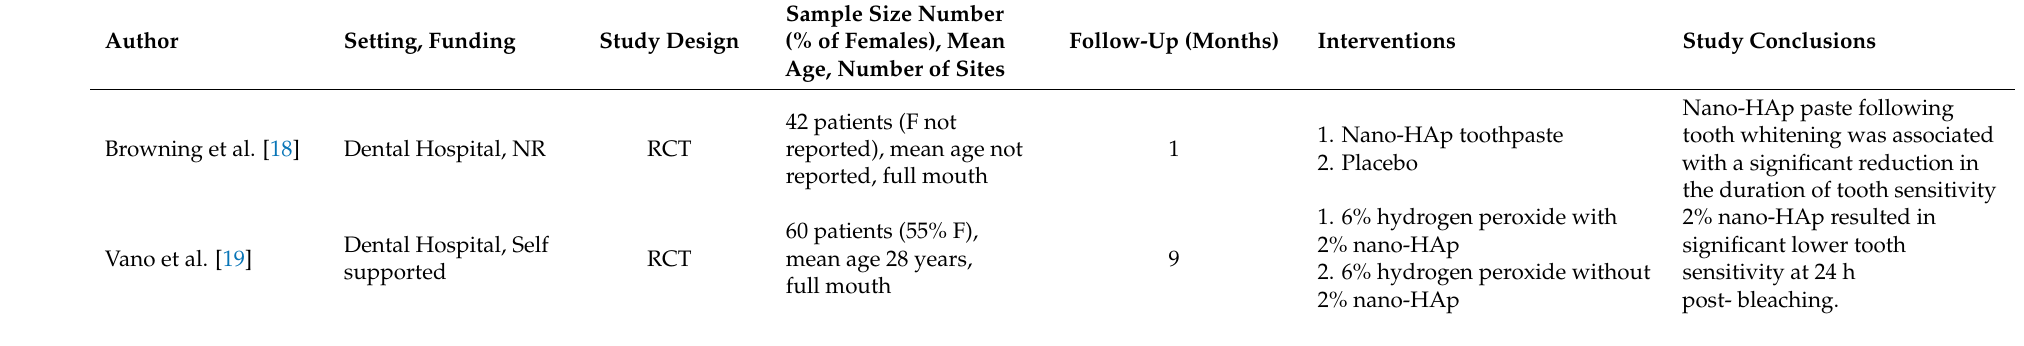
Table 2. Summary of Nano-HAp application in dentin